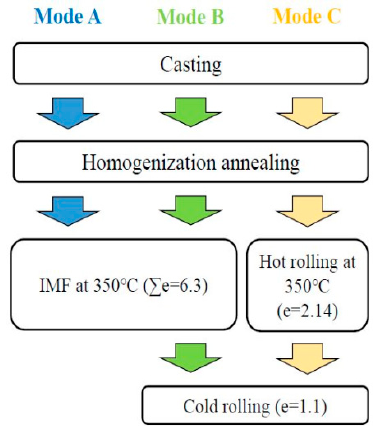
Figure 1. The thermo-mechanical treatment regimes (modes A, B and C).